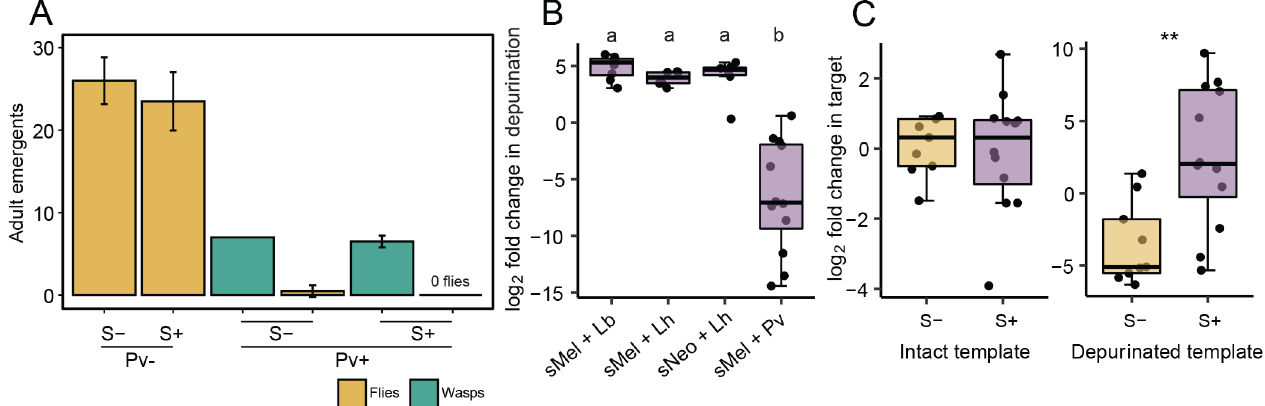
Fig 5. The ectoparasitic wasp Pachycrepoideus vindemmiae successfully develops in Spiroplasma -positive Drosophila melanogaster and does not show evidence of RIP attack. Pachycrepoideus vindemmiae (Pv) successfully parasitizes Spiroplasma -positive D . melanogaster (A). Neitherfly nor wasp emergence was significantly affected by the presenceof Spiroplasma ( p (cid:21) .5). The proportionof depurinatedribosomes is much less than what is seen in Leptopilina species ( p < .001; B). There is no difference in the level of intact P . vindemmiae ribosomesin s Mel- positive flies comparedto levels in s Mel-negative flies ( p = .778). Levels of depurinatedribosomes in s Mel-positiveflies are modestly, albeit significantly, greater than in s Mel-negative flies ( p = .004; C). Twelve s Mel-positive and nine s Mel-negative fly pupae were tested for RIP activity and jitter points are the mean of two technicalreplicates per wasp-infested larva. Significant comparisons from Tukey post hoc tests are labeled above boxplots.